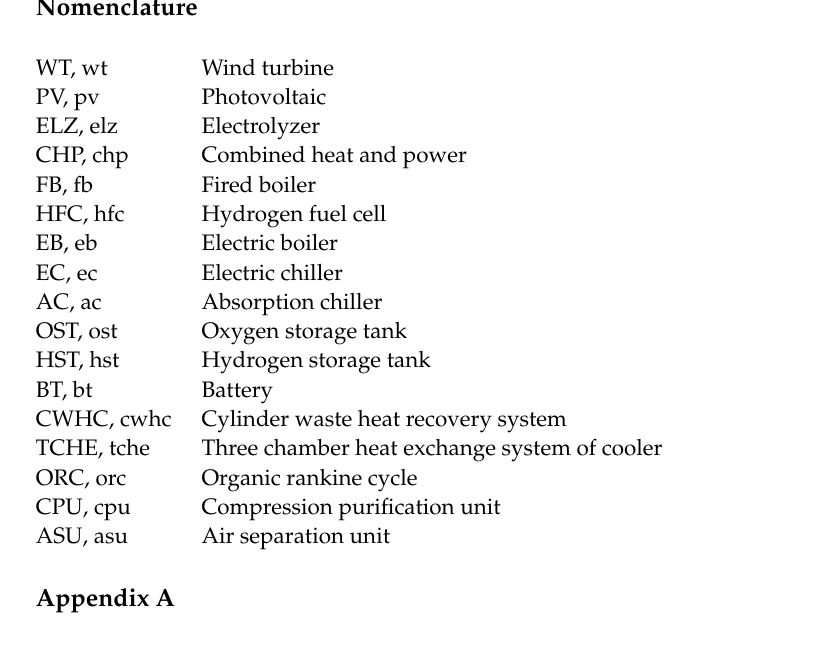
Table A1. Values of fixed technical and economical parameters in Case